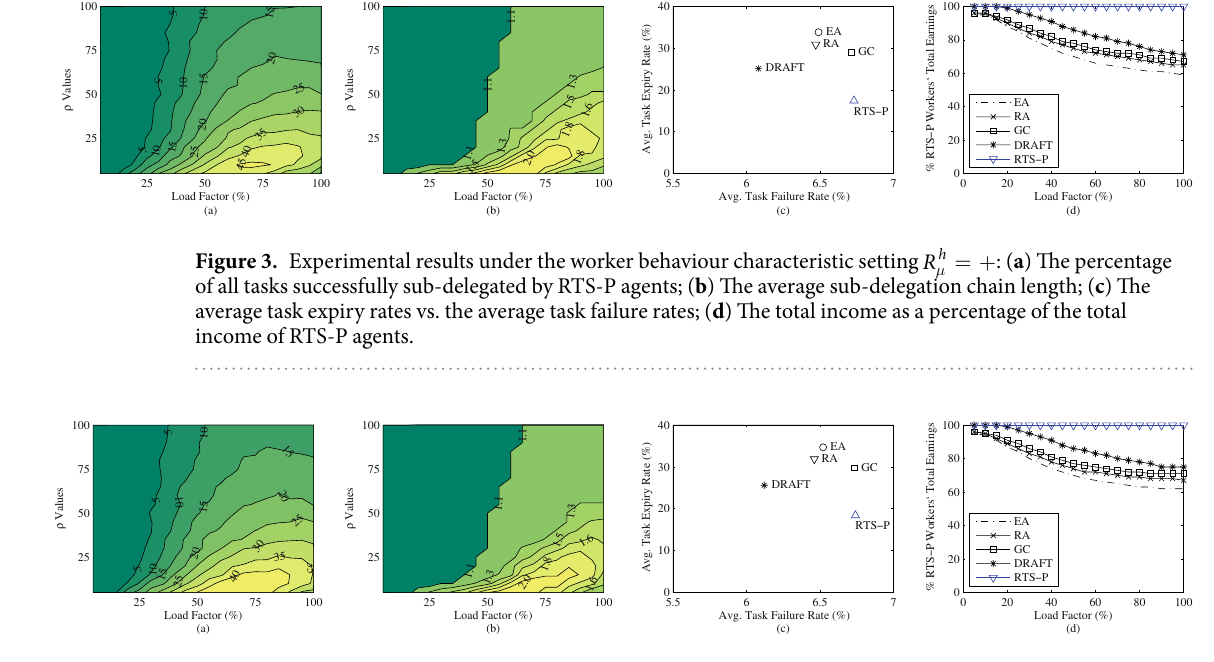
Figure 4. Experimental results under the worker behaviour characteristic setting = μ R 0 h : ( a ) The percentage of all tasks successfully sub-delegated by RTS-P agents; ( b ) The average sub-delegation chain length; ( c ) The average task expiry rates vs. the average task failure rates; ( d ) The total income as a percentage of the total income of RTS-P